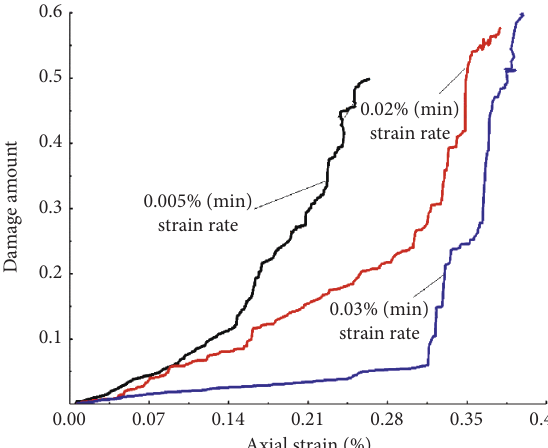
Figure 14: Corresponding curves of damage time under different unloading